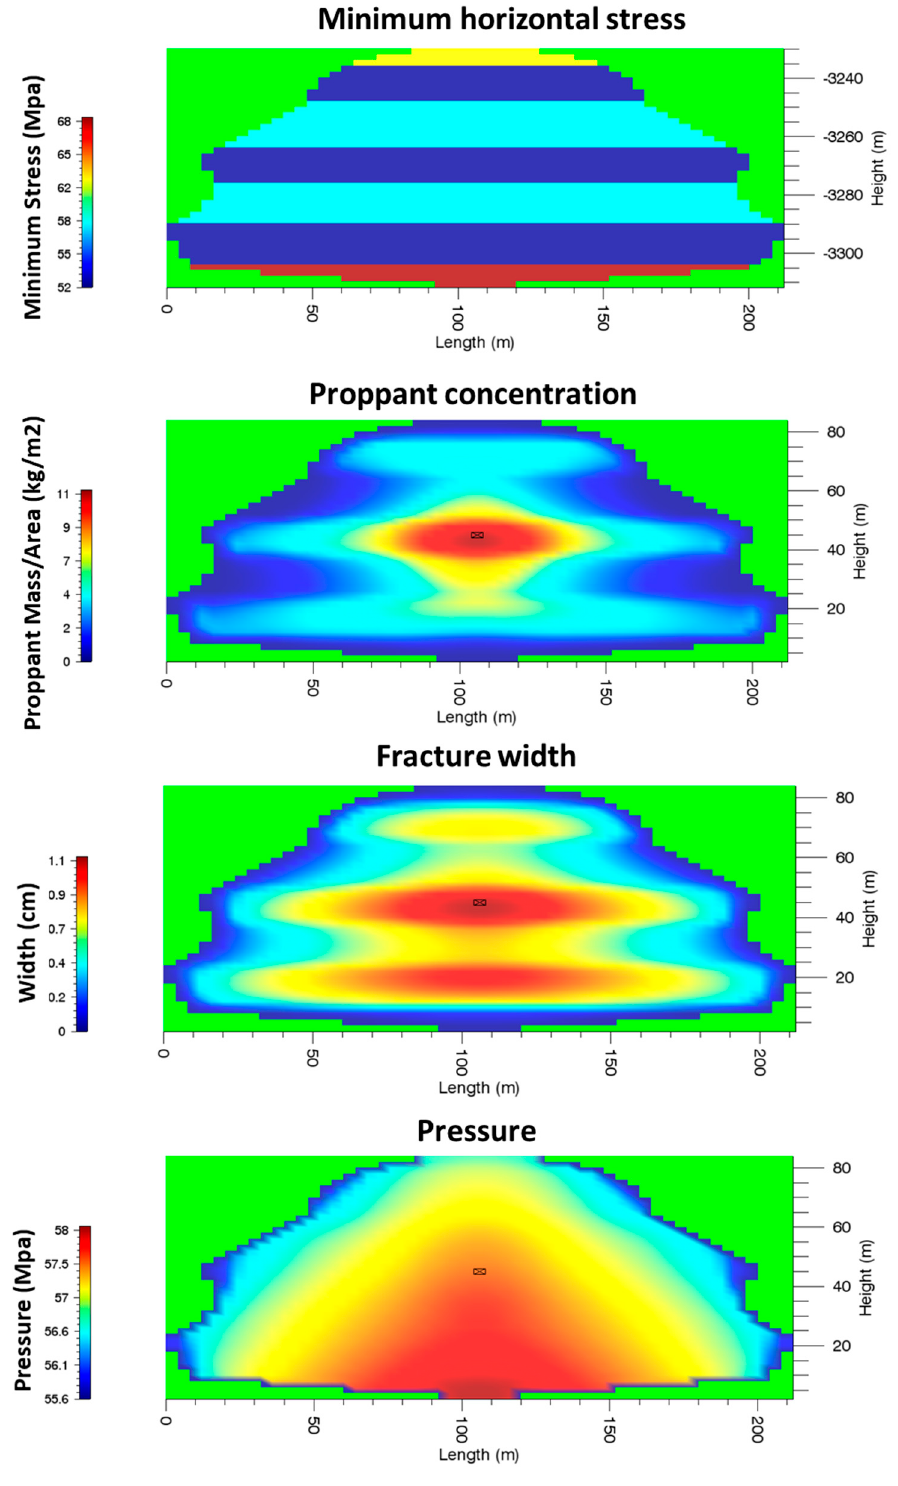
Figure 12. The stress profile, fracture width, proppant concentration and fluid pressure across the fracture of Case 1.